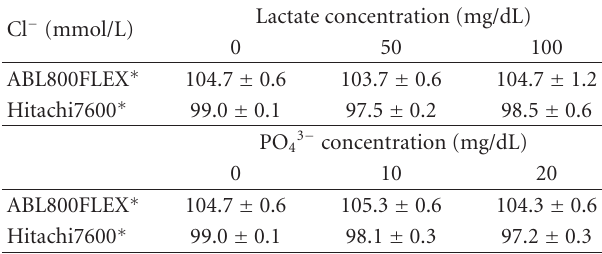
Table 2: Chloride concentrations measured by two analyzers in samples containing 3.5% albumin-acetate Ringer’s solution supple- mented with di ff erent ionic concentrations of lactate or phosphate.